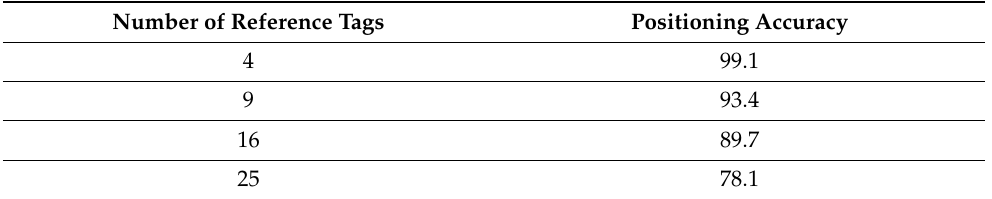
Table 3. The accuracy of tags in 1-Nearest Neighbor